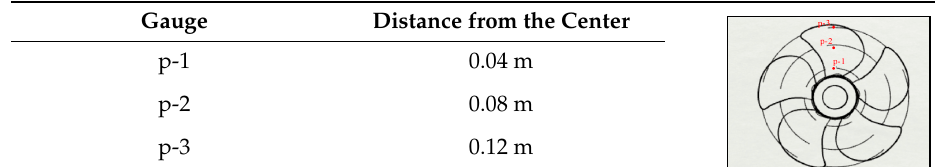
Figure 4. Pressure ( top ) and velocity ( bottom ) contours for different advance coefficients.